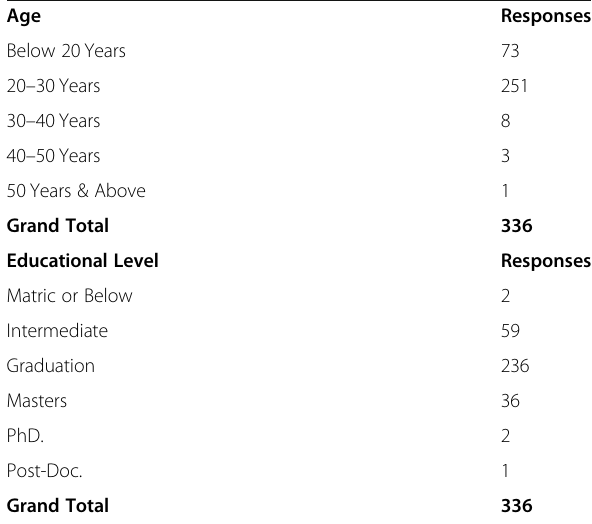
Table 2 Demographics - responses vs age group and education